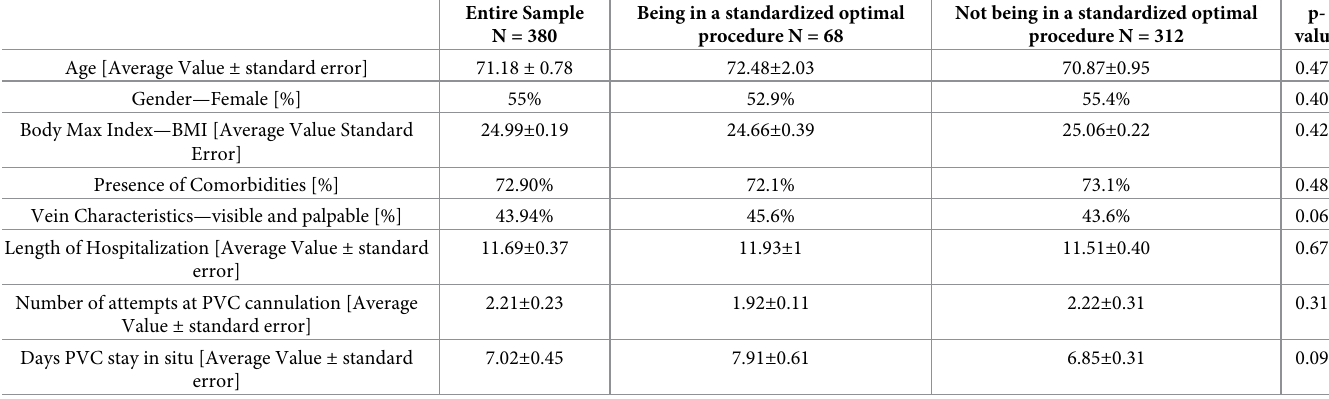
Table 1. Description of the sample under assessment.